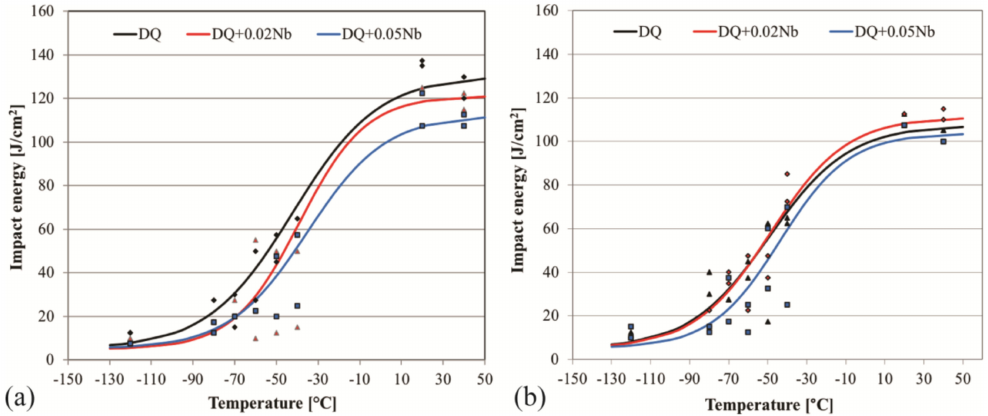
Figure 15. Longitudinal Charpy V-transition curves of investigated steels, ( a ) 920 ◦ C, ( b ) 820 ◦ C. Half-size Charpy specimens.